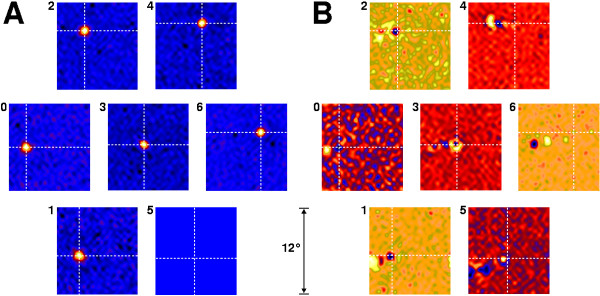
Retinal RFs of simultaneously recorded LERG and MUA. Simultaneously recorded retinal LERG- (A) and MUA-RFs (B). Individual RF maps are interpolated and arranged according to the hexagonal electrode array configuration. A: All LERG-RFs are congruent with the projected electrode tip positions (white crosshairs). The LERG from electrode 5 was not available in this recording due to an amplifier failure. B: The MUA-RF maps exhibit multiple spatially segregated peaks of positive or negative polarity that are shifted to the left from the projected electrode position. The optical disk is located in the upper right. Color coding as explained in Fig. 1. (Data from experiment 140, right eye)